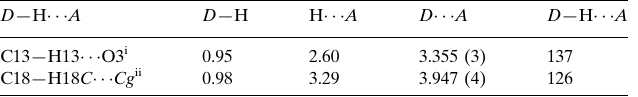
Hydrogen-bond geometry (A˚ , (cid:1) ). Cg is the centroid of the C9–C14 phenyl